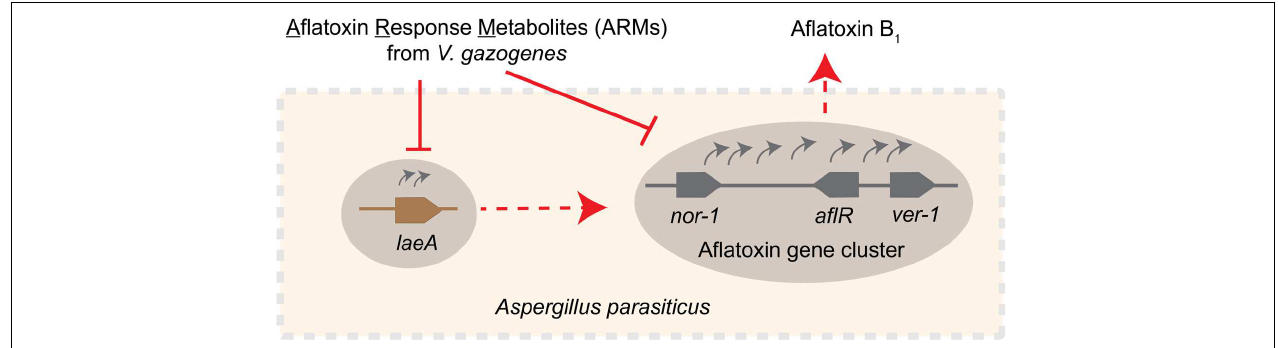
FIGURE 7 | Schematic representation of the inhibitory effect of ARMs on aflatoxin biosynthesis. Current study demonstrates that ARMs inhibit aflatoxin biosynthesis in A. parasiticus at the level of gene expression. We hypothesize that the inhibition of aflatoxin genes as exemplified by the decreased nor-1 , ver-1 , and aflR transcripts in presence of ARMs can be the effect of one or both of the following: (1) inhibition of laeA expression, which in turn can have inhibitory impact on the activation of the aflatoxin genes, or (2) a dual inhibition caused by direct inhibition on aflatoxin gene cluster activation along with a laeA mediated inhibition. Red dotted arrows, regulatory roles established in previous studies, red solid lines, inhibitory effect, gray curved arrows, gene activation, gray solid line, schematic of the aflatoxin gene cluster showing relative positions of nor-1 , ver-1, and aflR in the cluster, brown solid line, laeA